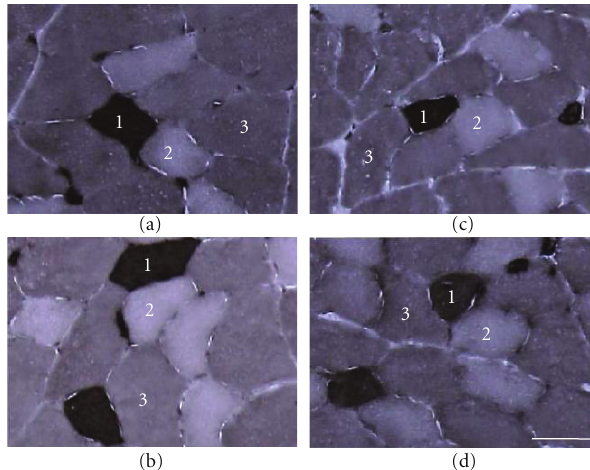
Figure 2: Transverse sections of the extensor digitorum longus muscle preincubated at pH 4.45 assayed for myofibrillar ATPase staining. (a) LC group; (b) LH group; (c) OC group; (d) OH group. 1: type I fiber; 2: type IIA fiber; 3: type IIB fiber. Bar = 50 μ